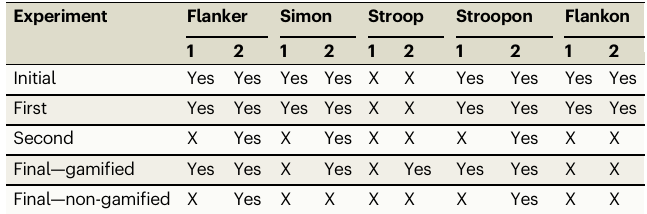
Table 1 | Tasks used in each experiment Experiment